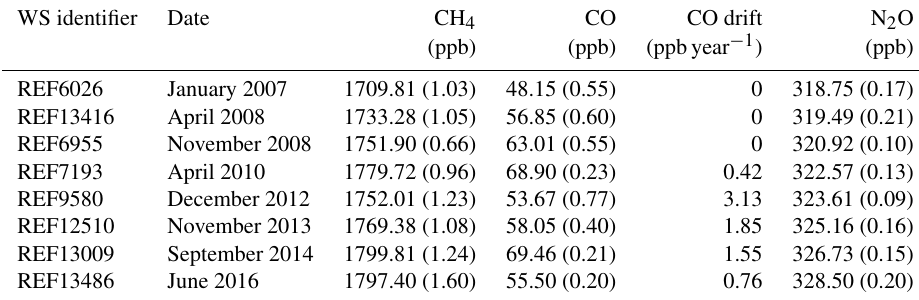
Table 3. Working standards consumed by the FTIR. WS CH 4 , CO and N 2 O dry mole fraction assignment with 1 σ uncertainty bracketed. Working standard tank date of attachment to the FTIR, tank identifier and calculated CO drift rates are given. The CH 4 , CO and N 2 O assignments are traceable to the WMOx2004A (Dlugokencky et al., 2005), WMOx2014A (Novelli et al., 1991) and WMO2006A (Hall et al., 2007) reference scales